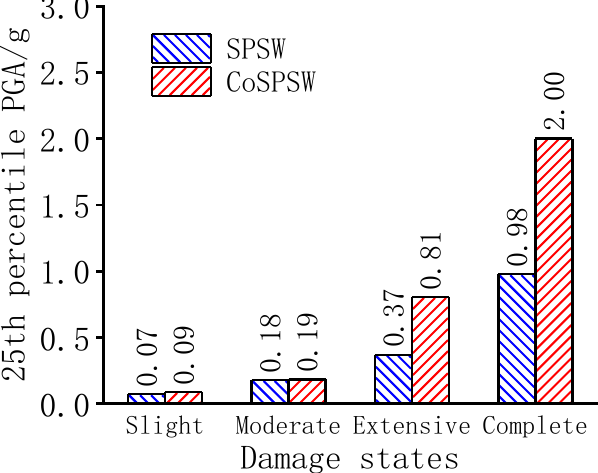
Figure 11. The 25th percentile PGA from structural fragility curves.